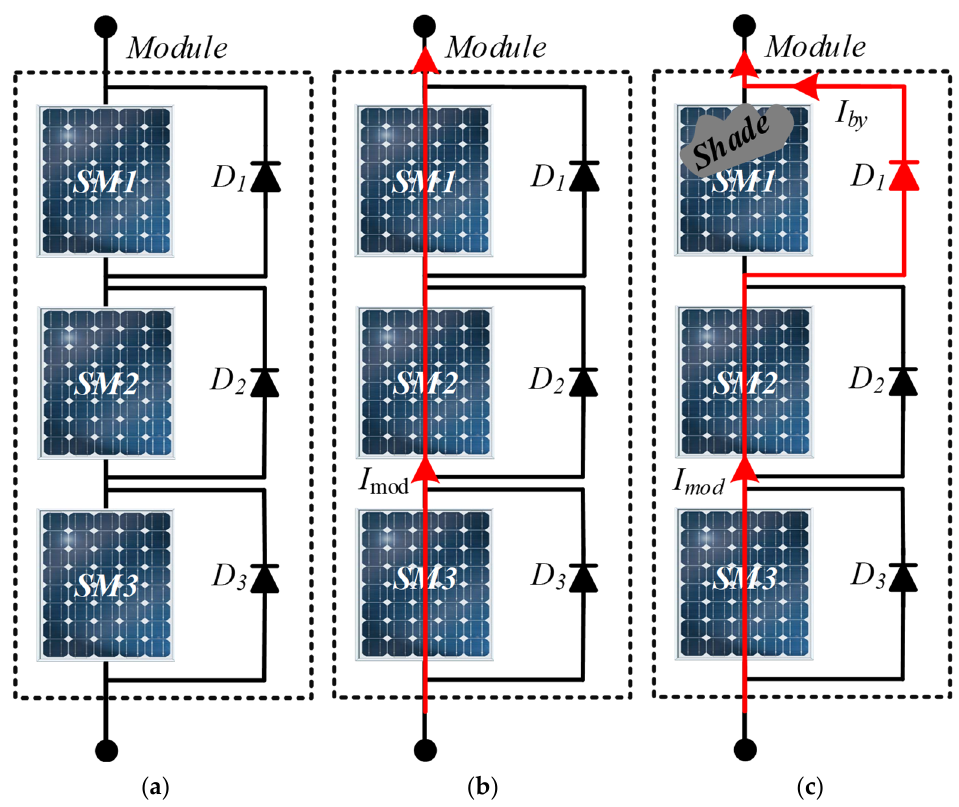
Figure 1. A PV module having three series-connected PV submodules ( SM1 , SM2 , and SM3 ): ( a ) General schematic diagram, ( b ) A schematic diagram when there is no mismatch (no shade), ( c ) Schematic diagram when SM1 is shaded. Here, D 1 , D 2 , and D 3 are parallel-connected bypass diodes. I mod and I by are the submodule and bypassing currents, respectively.